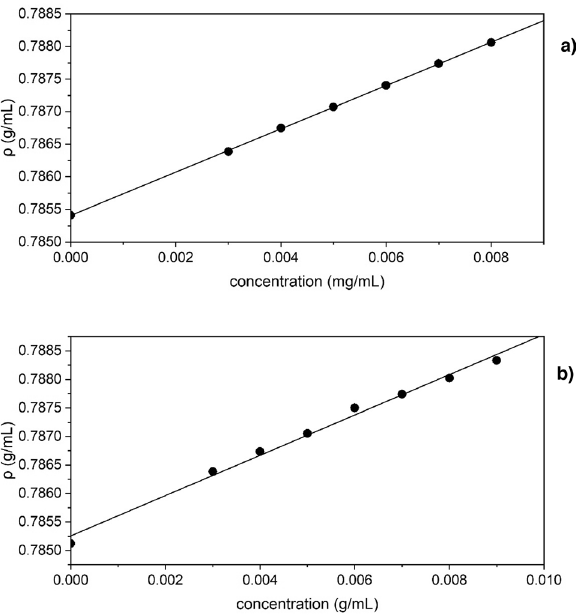
Figure 3. Dependence of solution density of TPA6 ( a ) and TPA7 ( b ) in isopropanol on